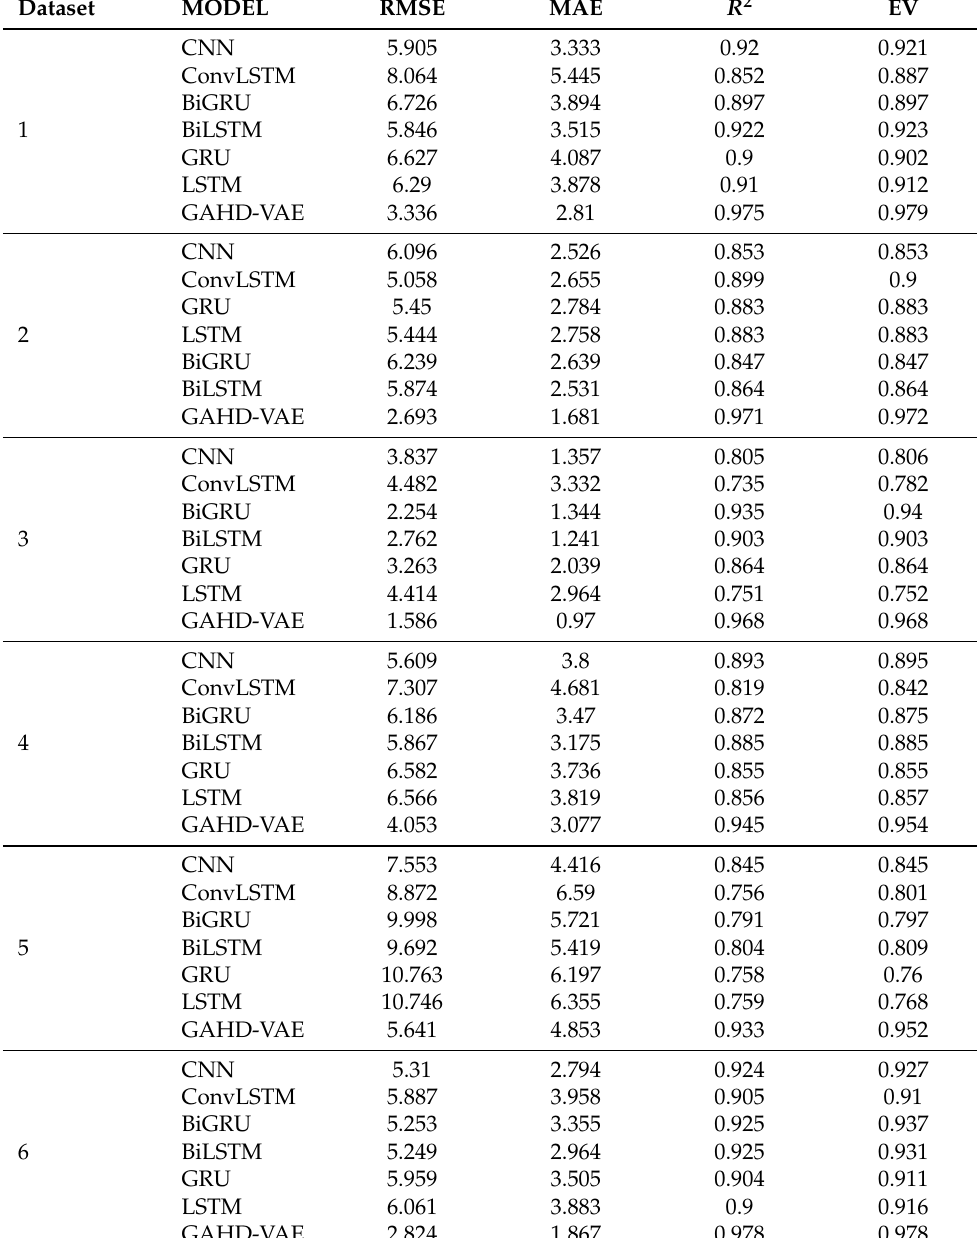
Table 4. One-step ahead forecasting of pedestrian and bicycle traffic flows using the seven deep learning models.